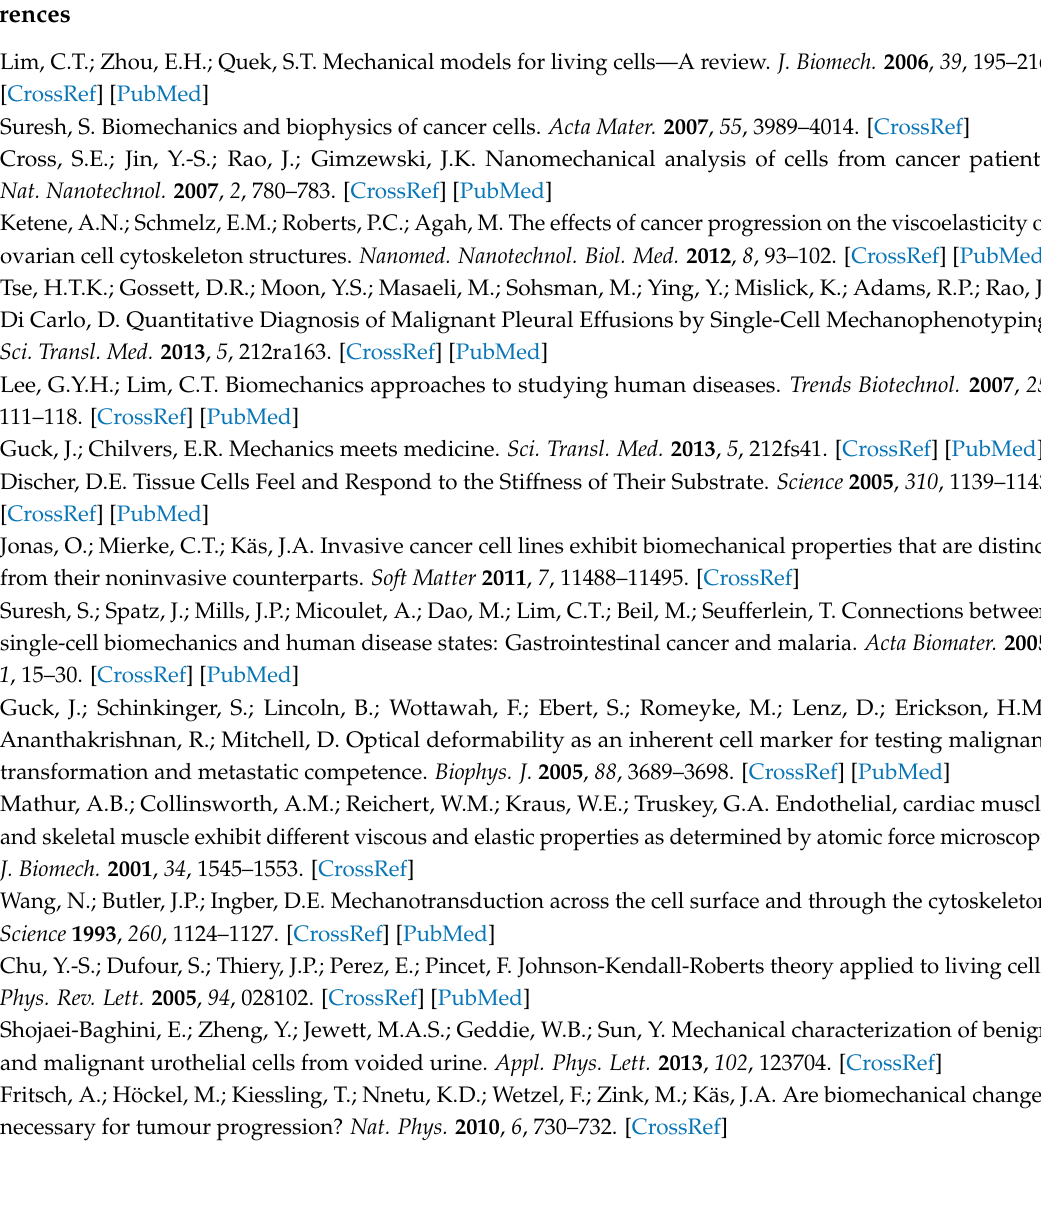
Figure S1: Schematic view of the assembly, Figure S2: Real-time stability measurements, Figure S3: Real-time frequency monitoring in glucose solutions with different concentrations, Figure S4: Real-time amplitude monitoring in glucose solutions with different concentrations, Figure S5: Real-time electrical